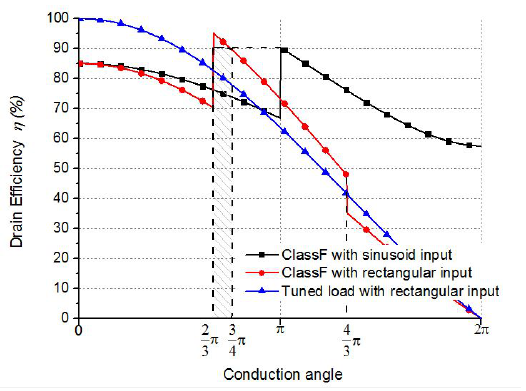
Figure 3. Useful biasing range for class-C-F power amplifier (PA) with respect to drain efficiency (DE).